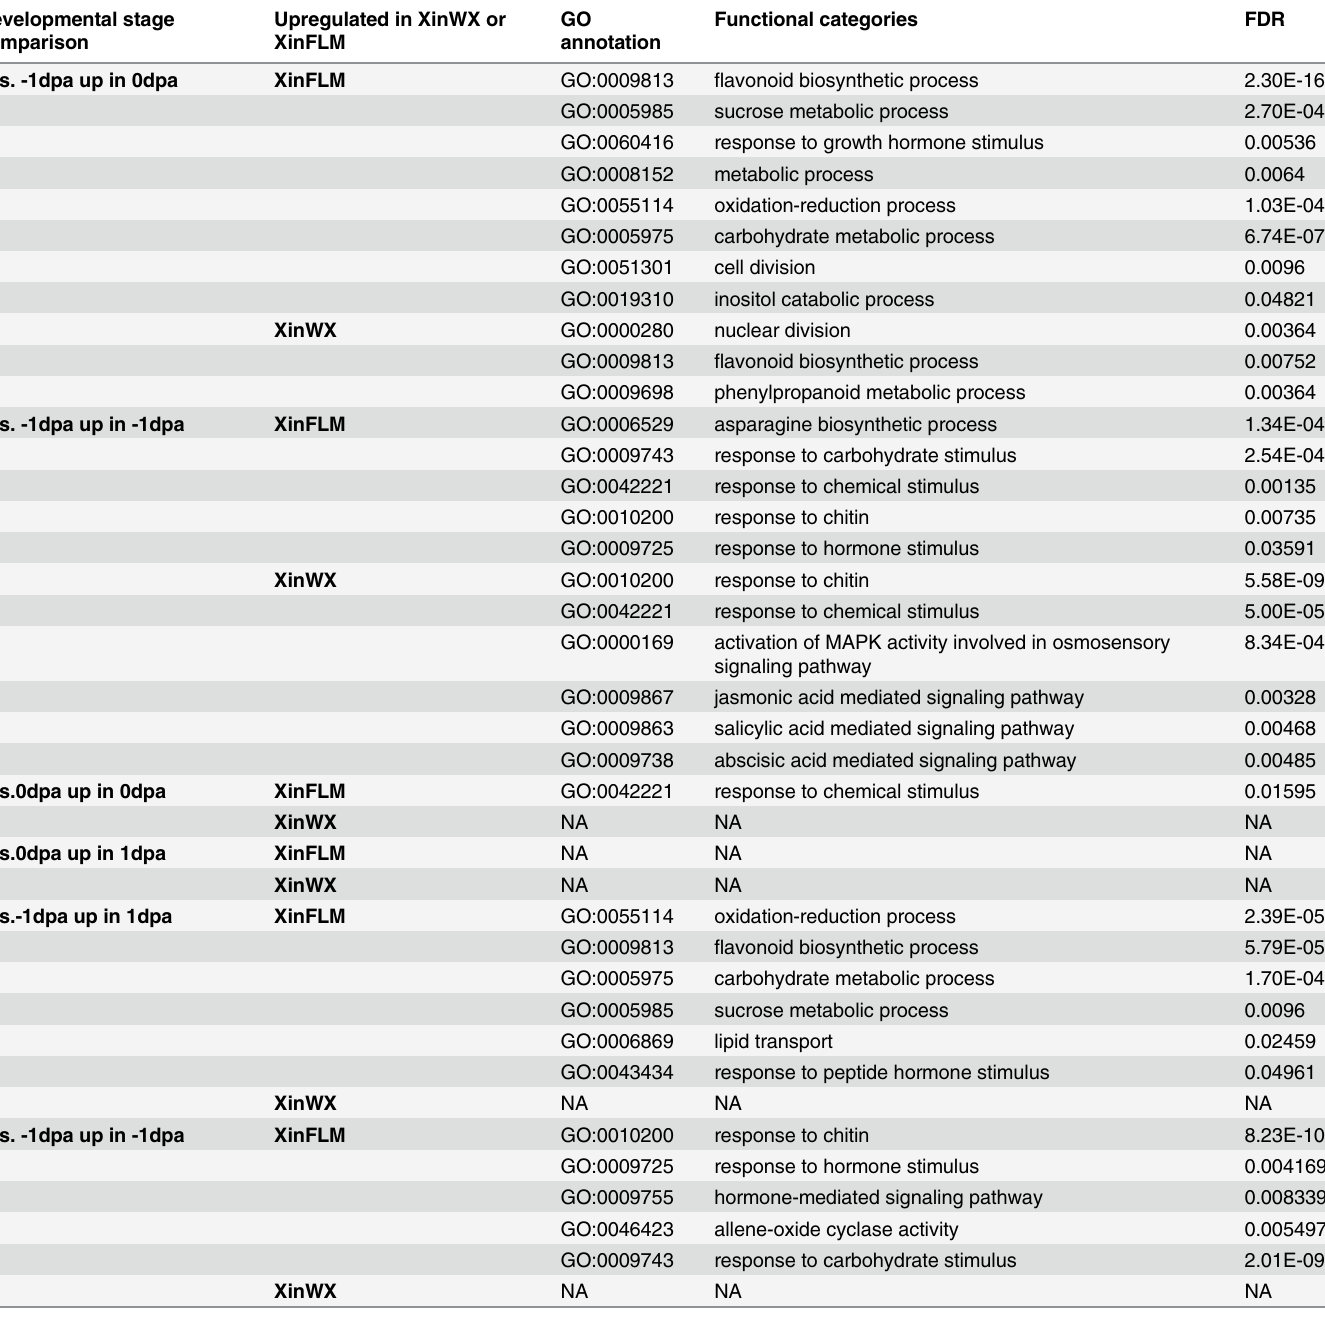
Table 1. Catalog of specific GO terms statistically over-represented during fiber initiation stages of XinWX and XinFLM. Developmental stage